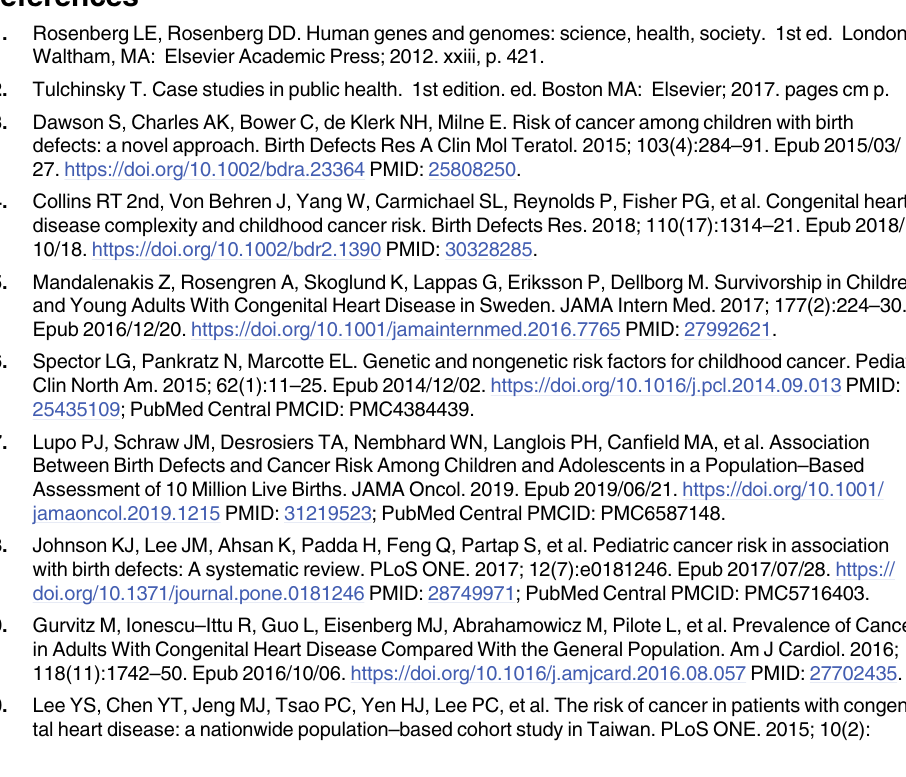
S6 Table. Adjusted HRs (95% CIs) of cancer in children with CHD diagnosed from the MBR. CHD, congenital heart disease; CI, confidence interval; CNS, central nervous system; HR, hazard ratio; MBR, Medical Birth